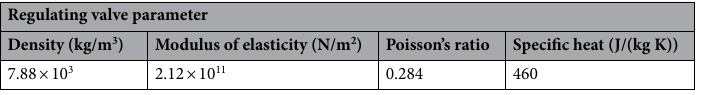
Table 2. Material characteristics of valve sleeve and valve